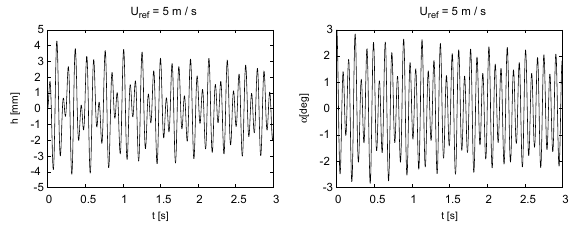
Fig. 9. Aeroelastic response for the seconde considered case in terms of h and α in time domain for far field velocity U ∞ = 5 m /